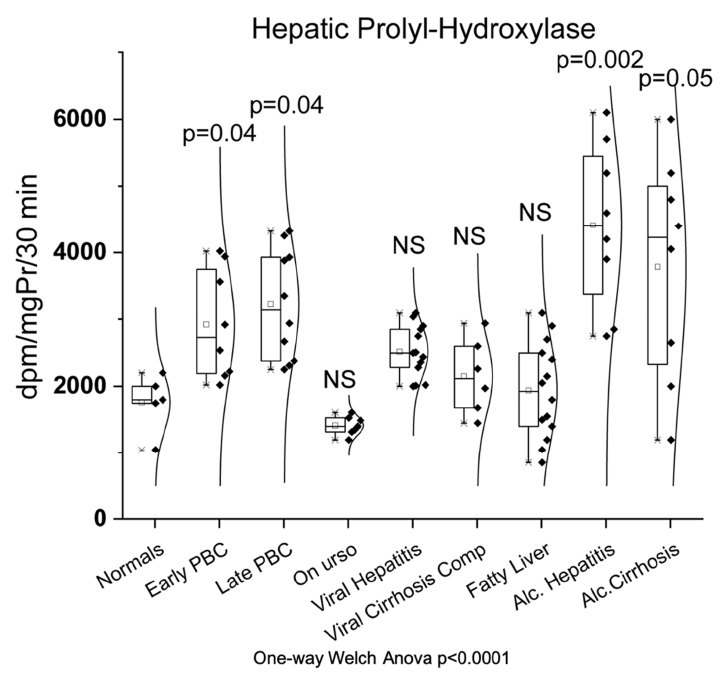
Figure 1. Enzymatic activity of hepatic prolyl hydroxylase in all studied groups. Box chart with points indicating the minimum, first quartile, median, third quartile, and maximum.